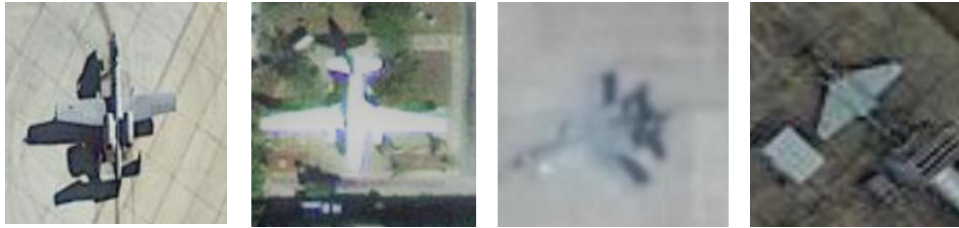
Figure 2. Aircraft examples of our dataset. The aircraft has obvious geometric features and symmetrical structure, and there are many redundant modes, which have strong long-distance